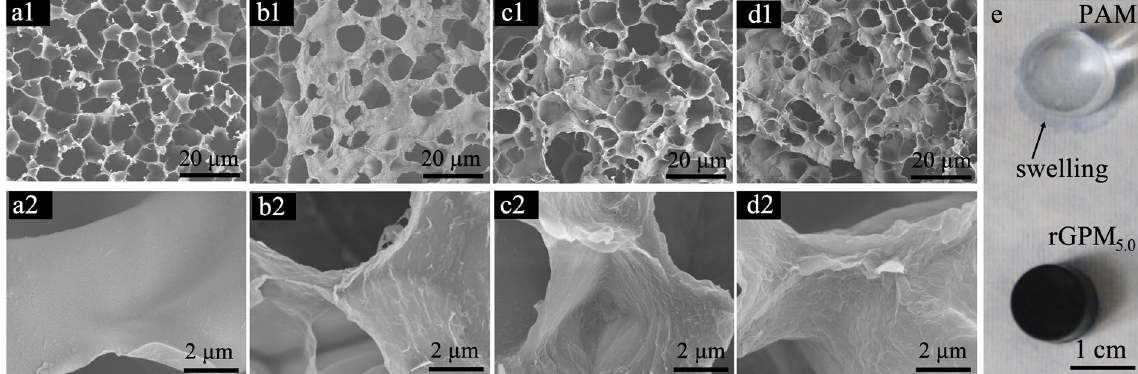
Figure 3. SEM images of PAM ( a1 , a2 ), rGPM 0 ( b1 , b2 ), rGPM 2.5 ( c1 , c2 ) and rGPM 5.0 ( d1 , d2 ); the photos of PAM (top) and rGPM 5.0 (bottom) placed on the paper for 6 min ( e